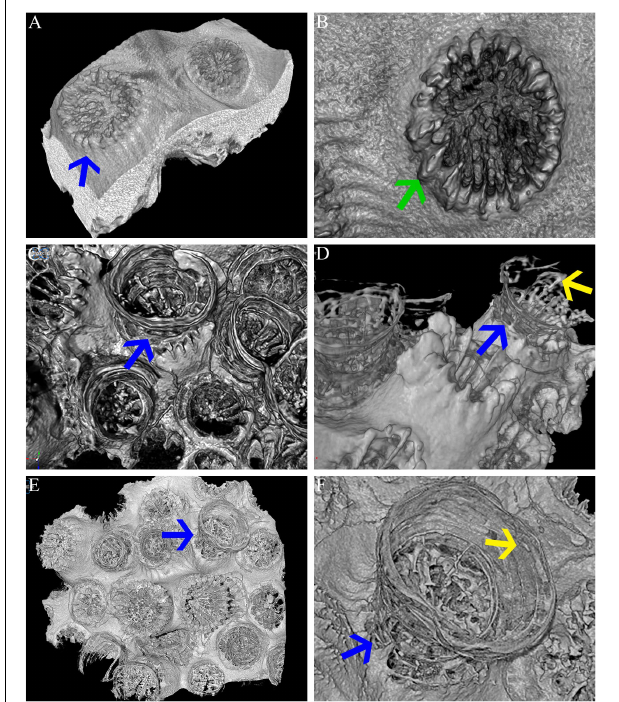
FIGURE 5 | O. patagonica ’s micromorphology. SEM images showing O. patagonica micromorphology for ambient-light (A,B) and the dark samples at the 12 (C,D) and 18 (E,F) time points. Green, red and blue regions indicate higher-magnification insets. The red arrows point to the coarser thecae and septa of the ambient-light samples compared to the smoother thecae of the dark samples (B,D,F) . Note (green arrow) the start of a costa formation in the Dark compared to the ambient-light (A,F) . Scale bar = 200 µ m.